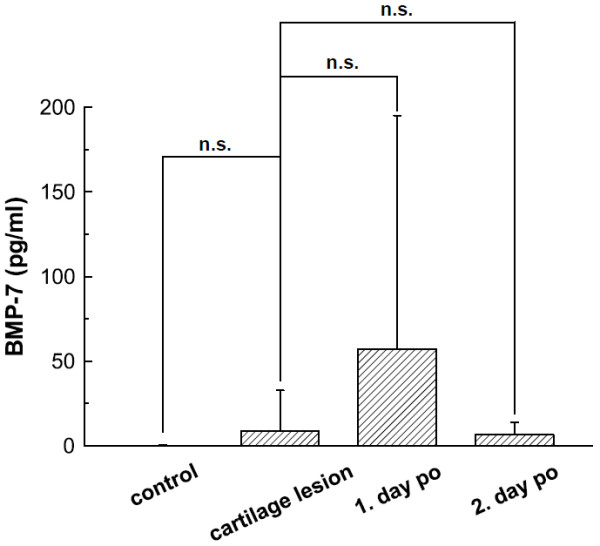
BMP-7 Course. BMP-7 content in lavage fluids of knee joints without cartilage lesions (control, n = 5), with cartilage damage (n = 42), following cartilage surgery at day 1 (n = 28) post operation (po), and following cartilage surgery at day 2 (n = 6) post operation. Groups were compared as indicated by the connecting lines, significance levels are specified.